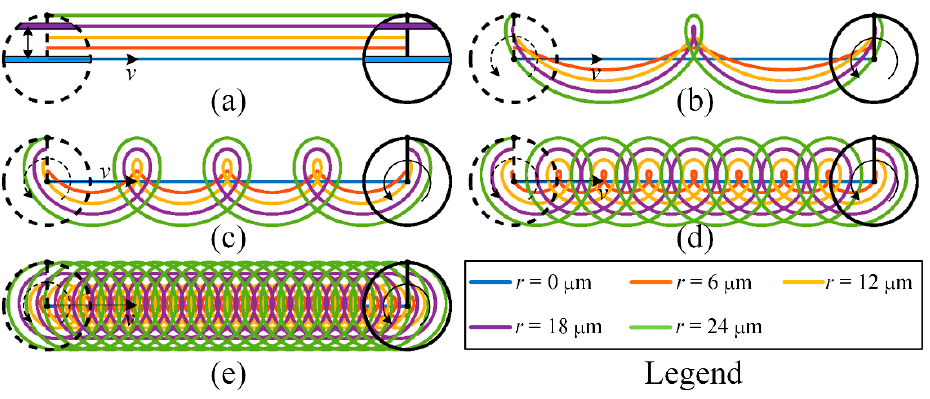
Figure 4. Differences in spatial motion trajectories of different points on the bottom surface of a cylindrical electrode when the rotation speed of the electrode is ( a ) 0; ( b ) 30; ( c ) 60; ( d ) 120; and ( e ) 300 rpm.